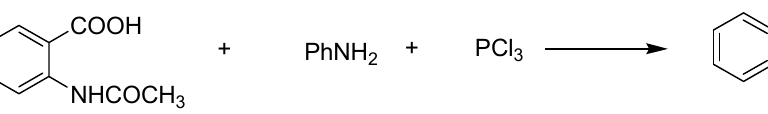
Figure 2. Synthesis of 3,4 dihydro-4-oxaquinazoline. Figure 3. Synthesis of 2-methyl-3-phenylquinazolin-4(3H)-one.